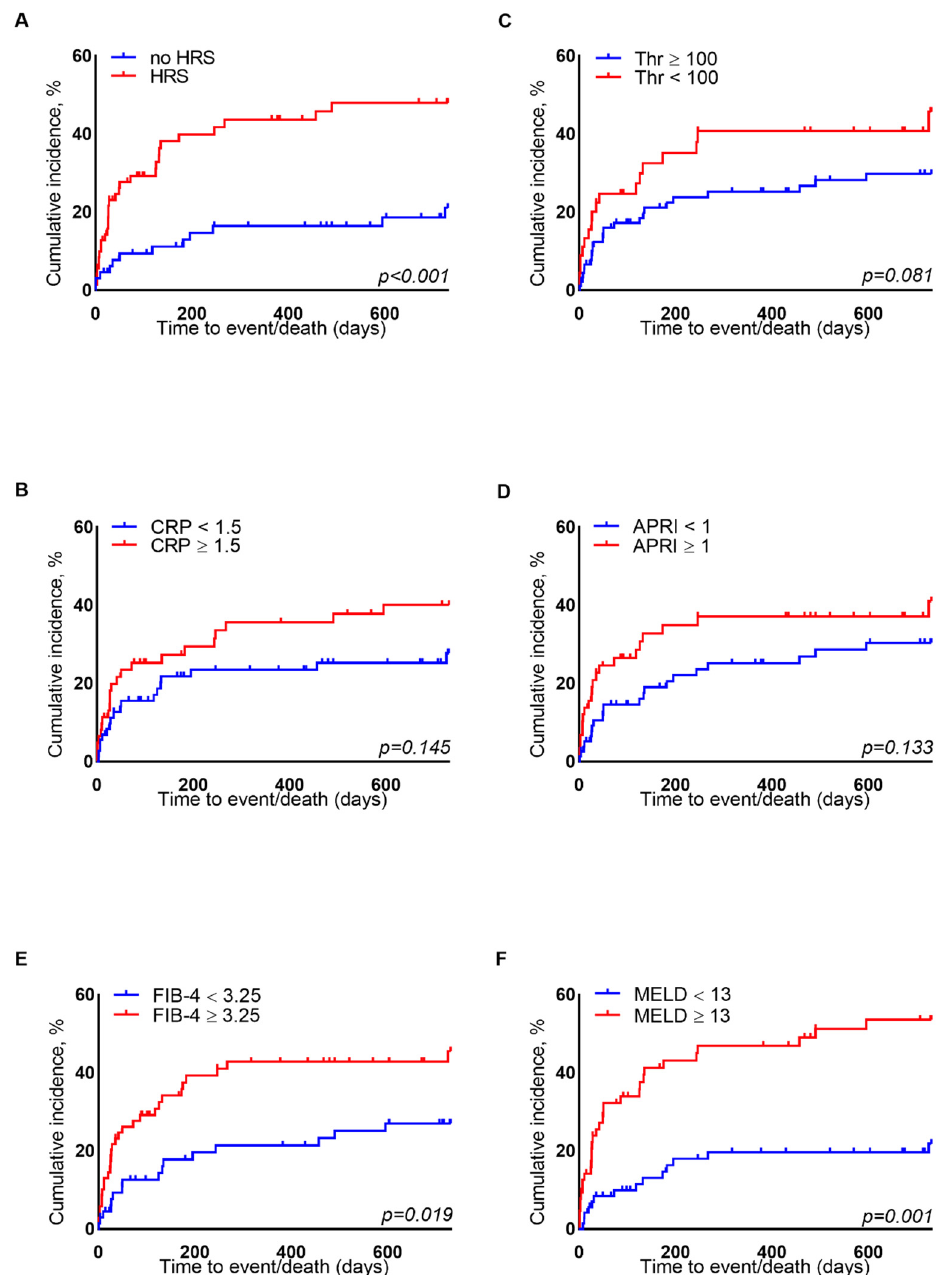
Figure 3. Cumulative event incidence for 730 days after TIPS insertion dependent on ( A ) HRS in the history (HRS vs. no HRS), ( B ) CRP levels (<1.5 mg/dL vs. ≥ 1.5 mg/dL), ( C ) platelet count ( ≥ 100/nL vs. <100/nL), ( D ) APRI (<1 vs. ≥ 1), ( E ) FIB-4 (<3.25 vs. ≥ 3.25) and ( F ) MELD score (<13 vs. ≥ 13). The p -values were obtained using the logrank test .